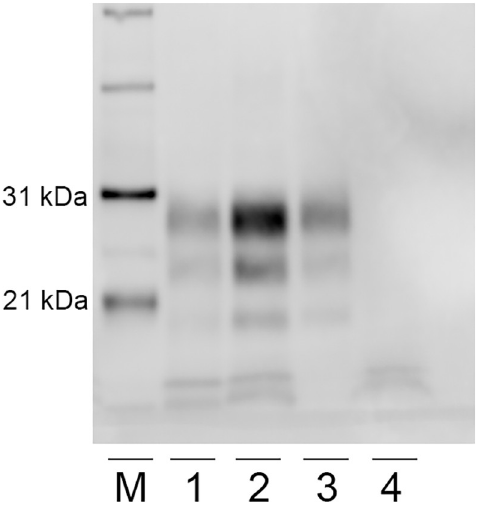
Fig 3. Western blot migration patterns of ovine scrapie. Proteinase K-digestion of brain homogenates from sheep orally inoculated with scrapie reveals three immunoreactive bands that represent three glycoforms (monoclonal antibody P4). Western blot analysis of PrP Sc reveals similar band patterns of brain homogenate prepared from a whole brain derived from a sheep from the second passage of the US No. 13–7 scrapie isolate in ARQ/ARQ sheep (lane 1), scrapie positive sheep (288) orally inoculated with autoclaved scrapie US No. 13–7 (lane 2), and scrapie positive sheep (242) orally inoculated with non-autoclaved scrapie US No. 13–7 (lane 3). Lane 4 represents a scrapie negative sheep (243) inoculated with autoclaved scrapie US No. 13–7. Two low molecular weight non-specific bands are present in lanes 1, 2, and 4. M: molecular weight marker.